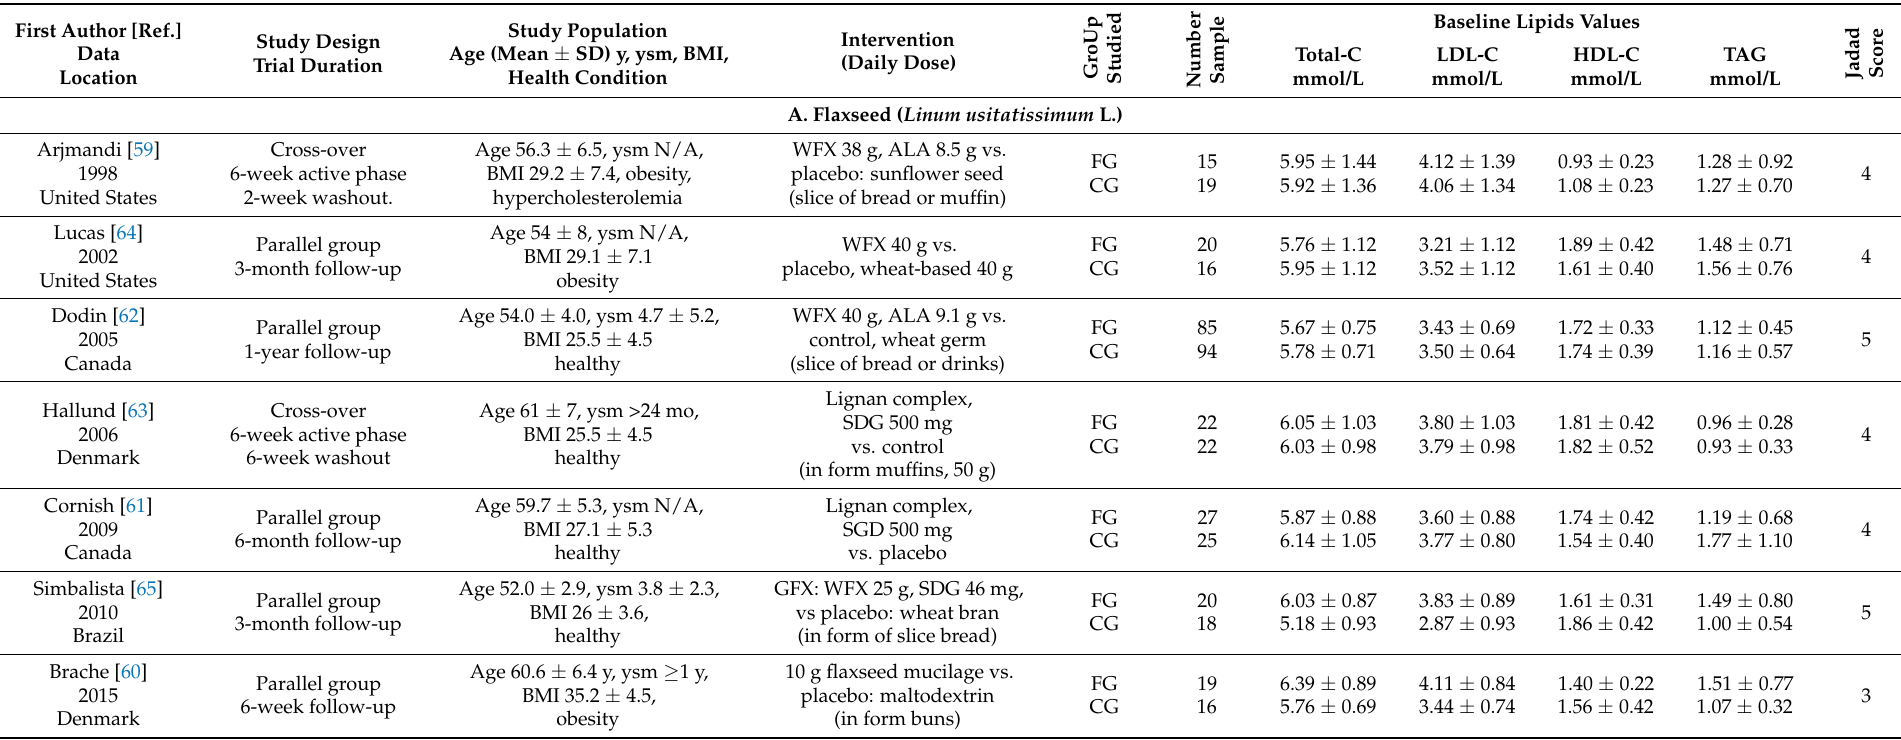
Table 1. Characteristics of selected randomized controlled studies assessing the influence of flaxseed, soy protein, soy isoflavones, and red clover on lipid profile in postmenopausal